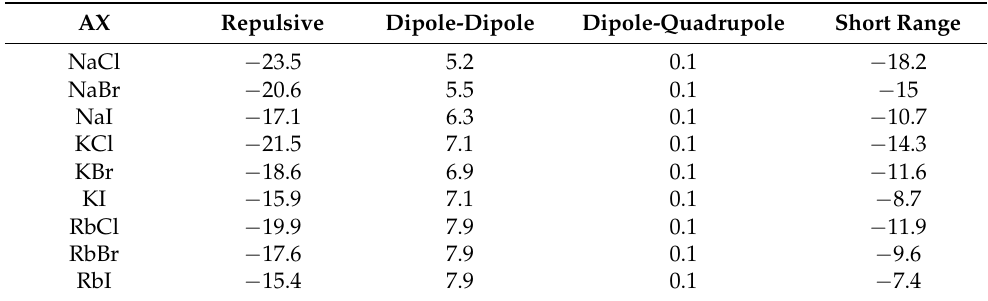
Figure 6. Graphical representation of ν 3 (i − BH 4 − ) as a function of the contribution of the short-range interaction energies in the corresponding AX. Dashed line is the linear regression. Table 5. Contribution of the short-range forces of the alkali halides as given by the Born–Mayer equation (in kg.cal.mol − 1